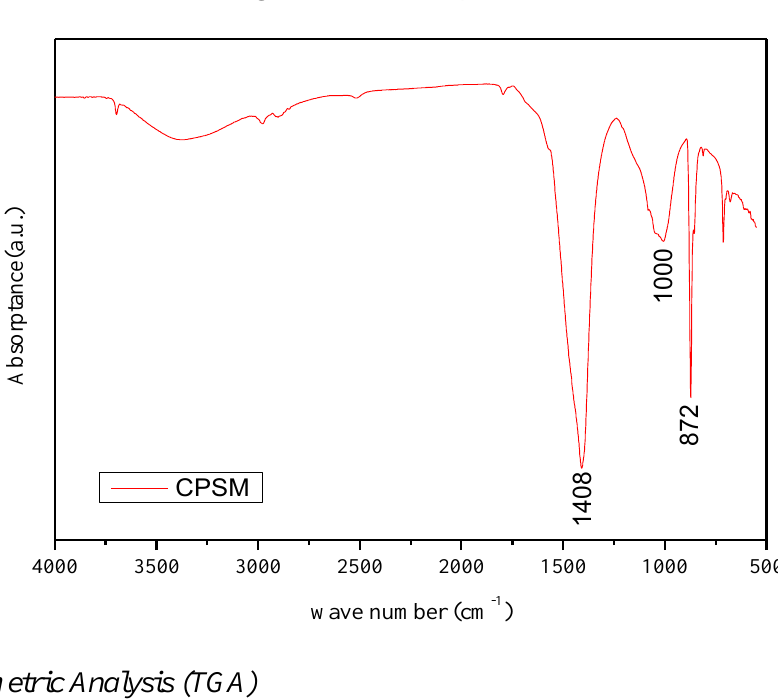
Figure 12. FT-IR